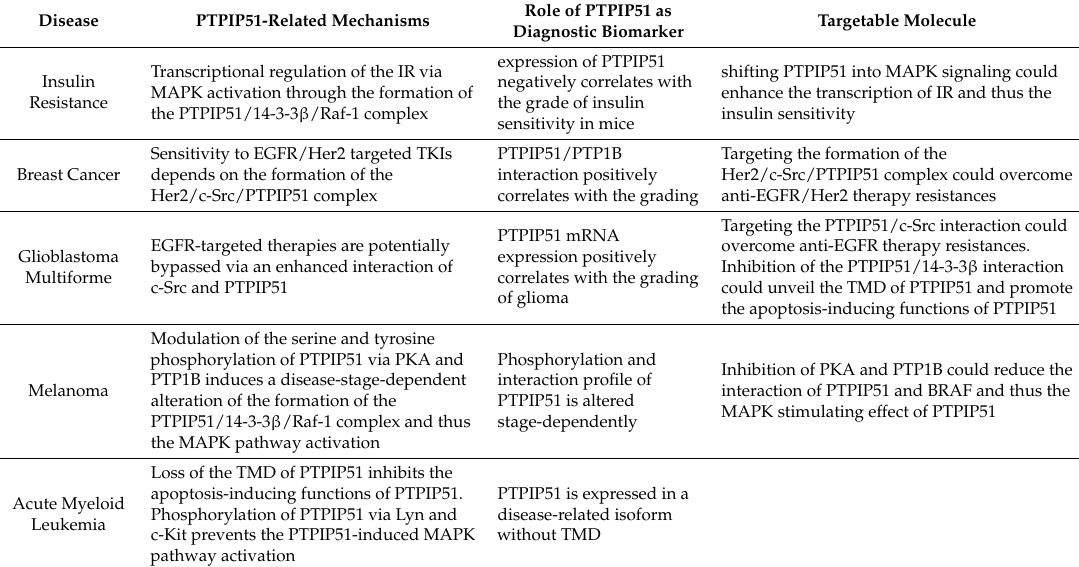
Table 1. Summary table of the PTPIP51-related mechanisms of the various diseases and their implications on the role of PTPIP51 as a potential biomarker and targetable